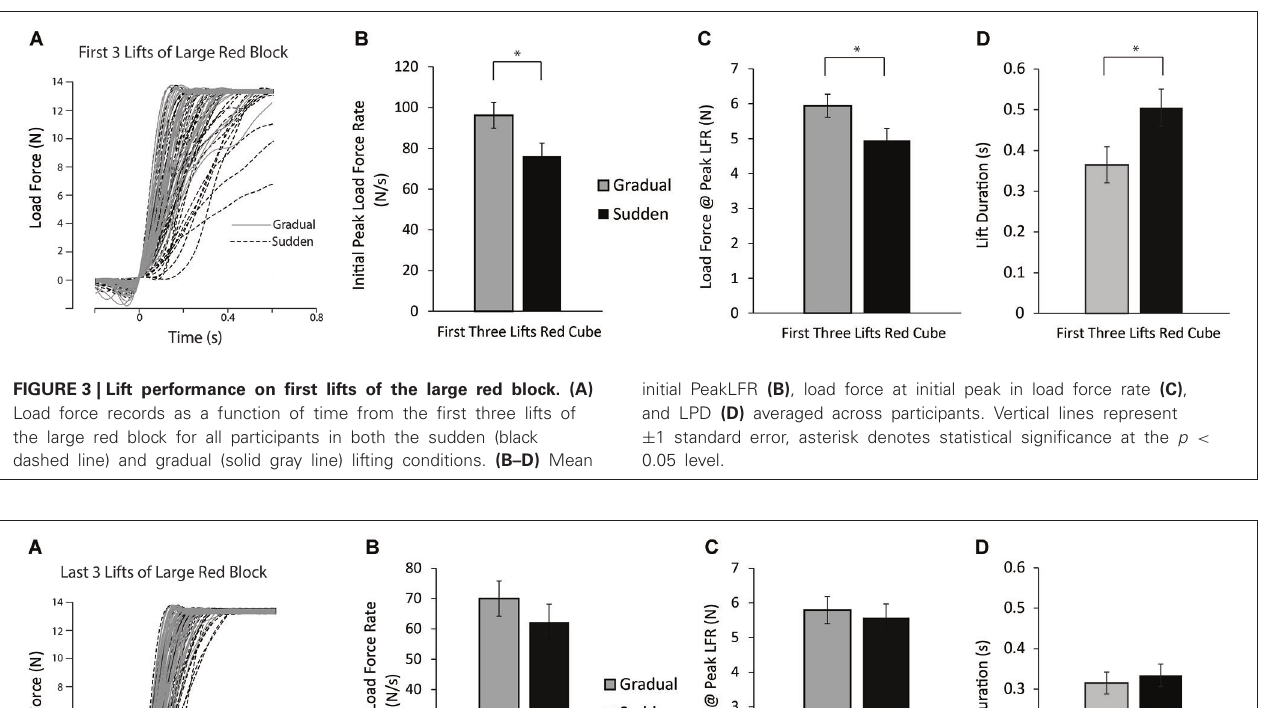
line) lifting conditions. (B–D) Mean initial PeakLFR (B) , load force at initial peak in load force rate (C) , and LPD (D) averaged across participants. Vertical lines represent ± 1 standard